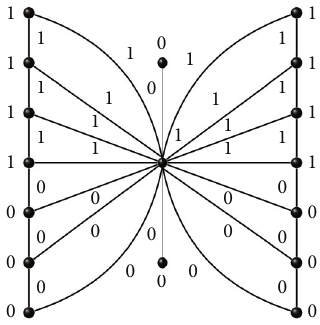
Figure 3: The dragon fl y graph Dg